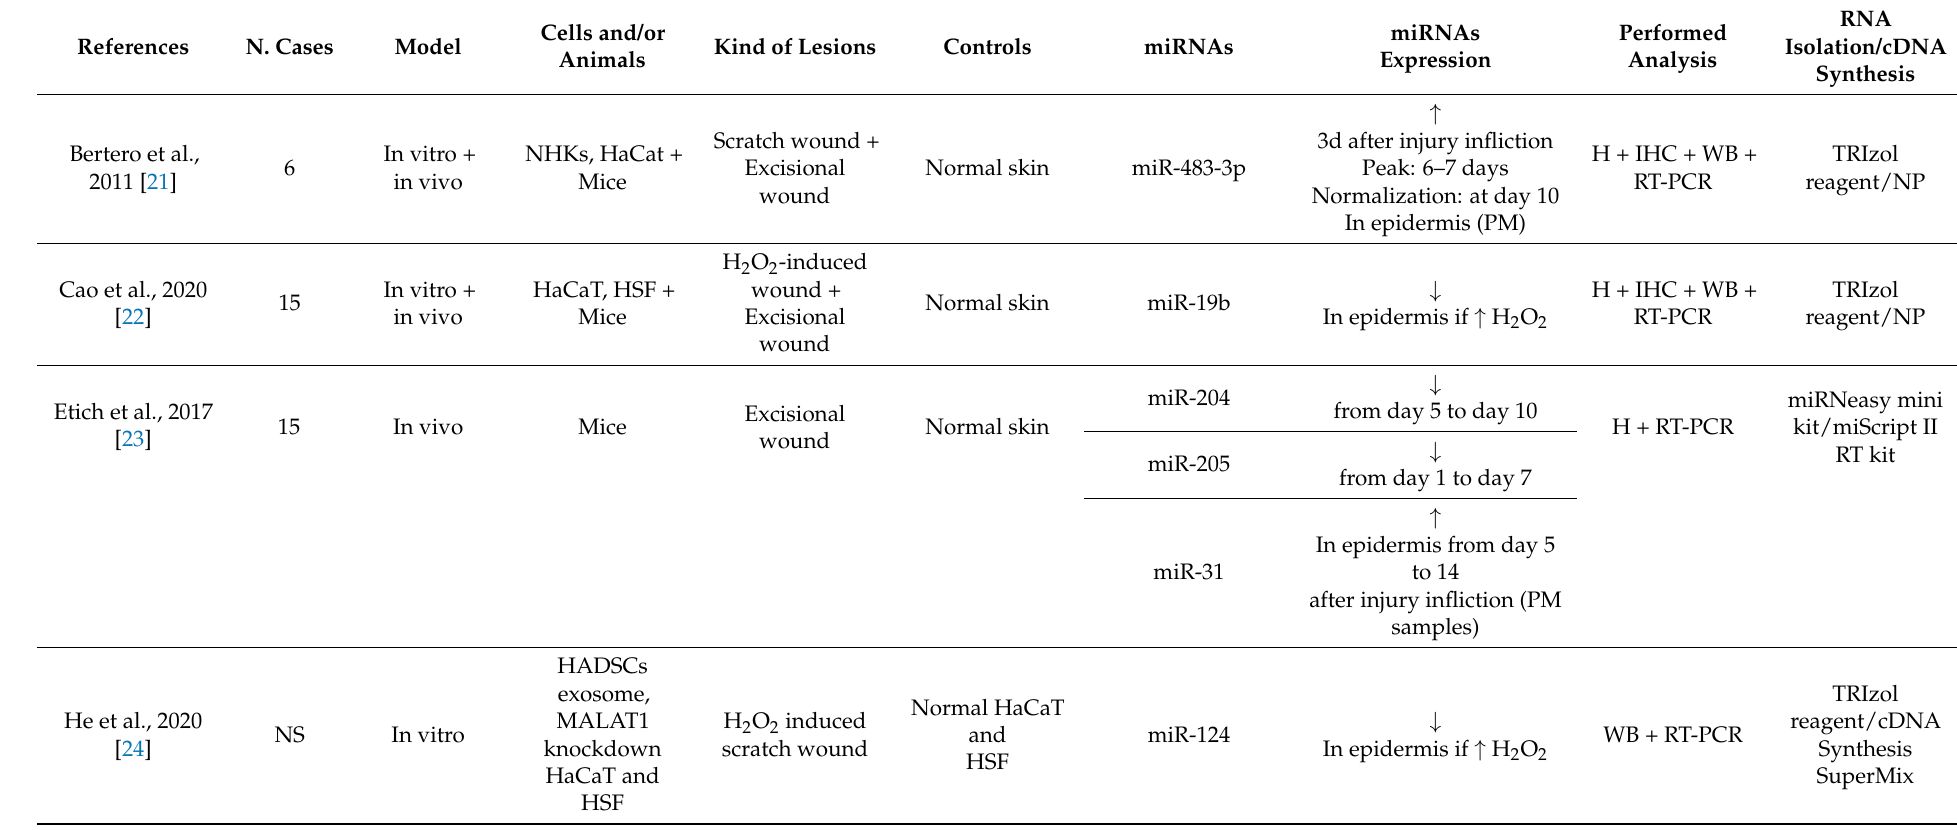
Table 1. This table resumes all the studies implied in our revision. RT-PCR, when reported, is quantitative. Statistical analysis was performed in all studies except in Viticchi è et al., 2012, Yang et al., 2011, and Yu et al., 2010. AM, antemortem; H, histology; HaCaT, human keratinocyte cell line; HCECs, corneal epithelial cells; HADSCs, human subcutaneous adipose tissue; HEKs, human keratinocytes; HSF, human skin fibroblasts; IHC, immunohistochemistry; IHF, immunohistofluorescence; ISH, hybridization in situ; MP, morphometric analysis; NP, not performed; NS, not specified; PM, post-mortem; PMC, phase contrast morphometry; RT-PCR, reverse transcription–polymerase chain reaction; WB, Western blot. Excisional wounds refer to the removal of the skin surface, while incisional wounds represent a linear cut on a cell layer. ↑ indicates up regulation, ↓ indicates down regulation.